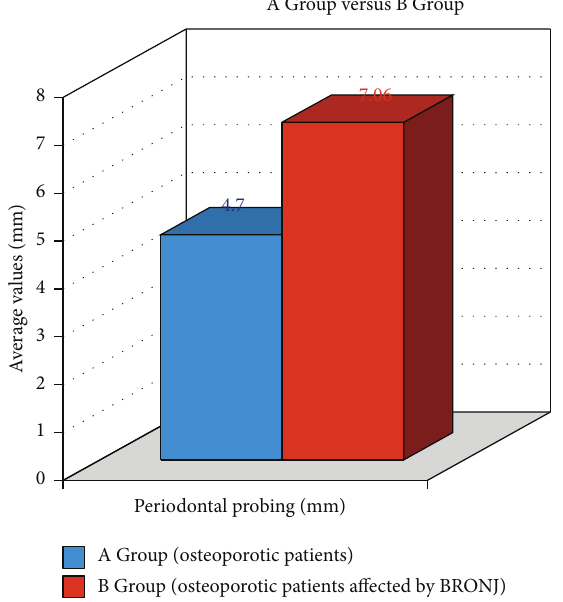
Figure 5: Periodontal probing average depth recorded for patients in each